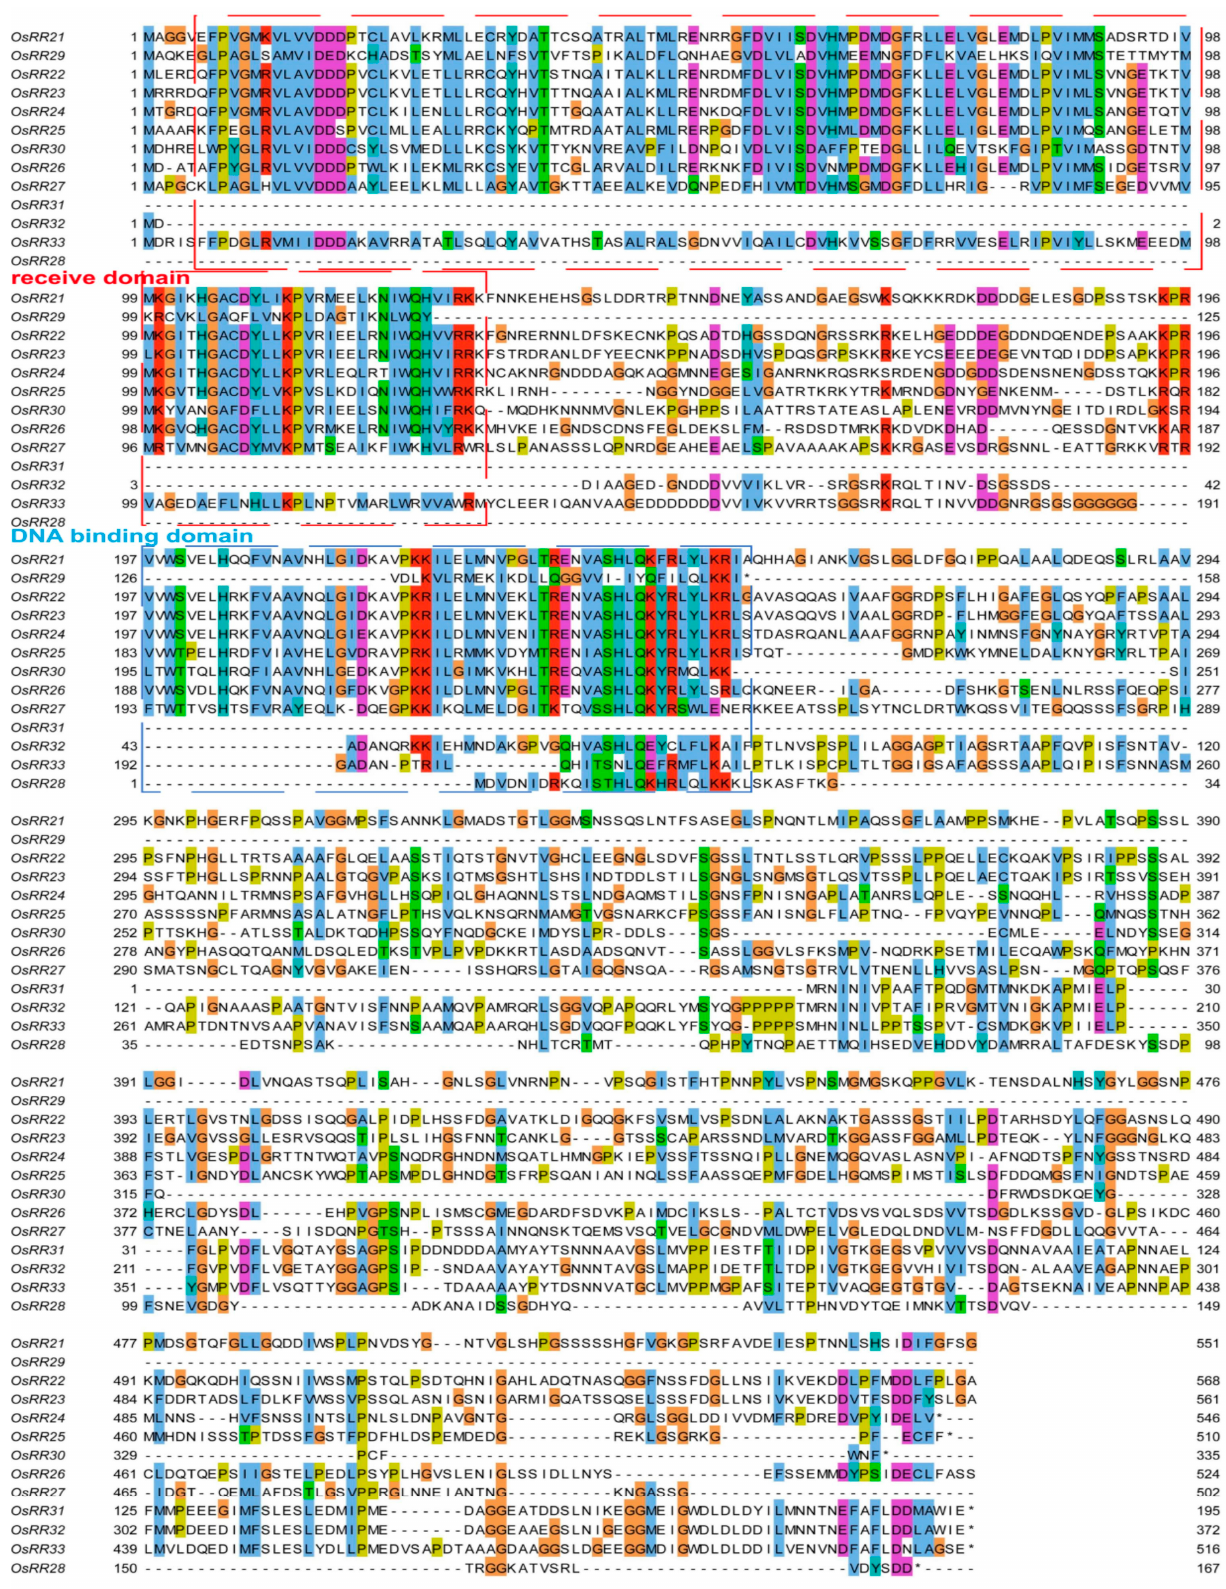
Figure 2. Multiple sequence alignment of type-B OsRRs. Red box indicates receive domain; blue box indicates DNA binding domain.